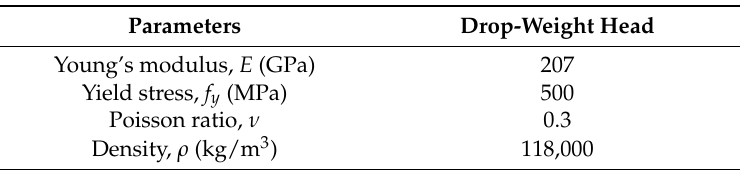
Figure 16. Numerical model for a multi-layer pavement slab under drop weight impact (quarter model). Table 11. Properties of the drop weight